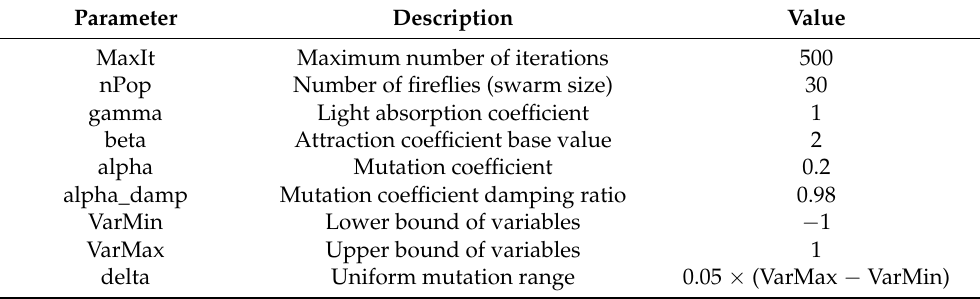
Table 3. Parameter setting of firefly